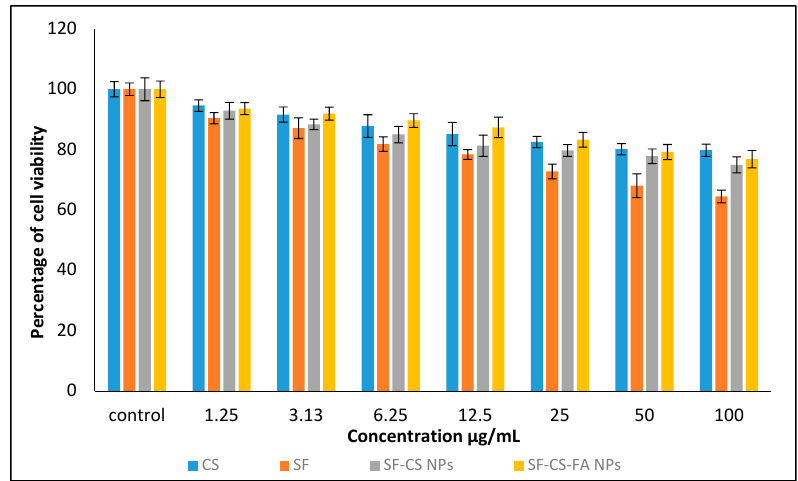
Figure 13. Cytotoxicity assay of chitosan, pristine sorafenib, CS-sorafenib, and CS-sorafenib-folic acid nanoparticles against normal HDFa dermal fibroblast cells at 72 h. Values are expressed as mean ± SD of triplicates. The significant differences were determined using the one-way ANOVA followed by Duncan’s Multiple Range Test.